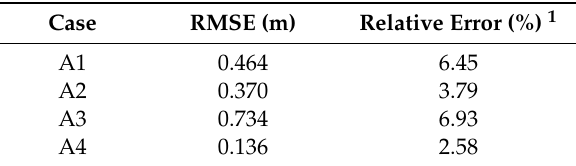
Figure 8. Comparisons between observed data (obs.) and prediction (pred.) in four test datasets of water level (m) versus time (hour) in domain: ( a ) third highest flood event, ( b ) second highest flood event, ( c ) highest flood event, and ( d ) moderate peak flood event. Table 7. Error evaluation of the CNN in Domain